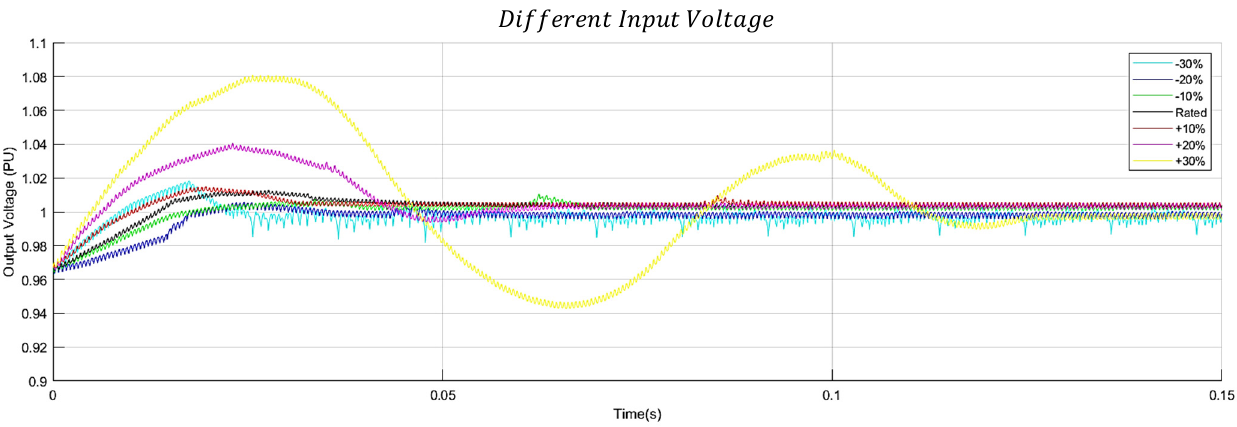
Figure 13. Behavior output voltage to step (550 to 600 V) for different input voltage with P out = 5.5 kW.